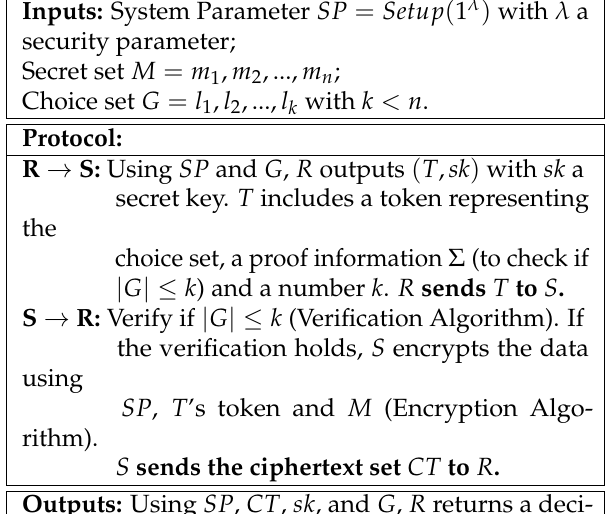
Figure 1. The OT k n scheme